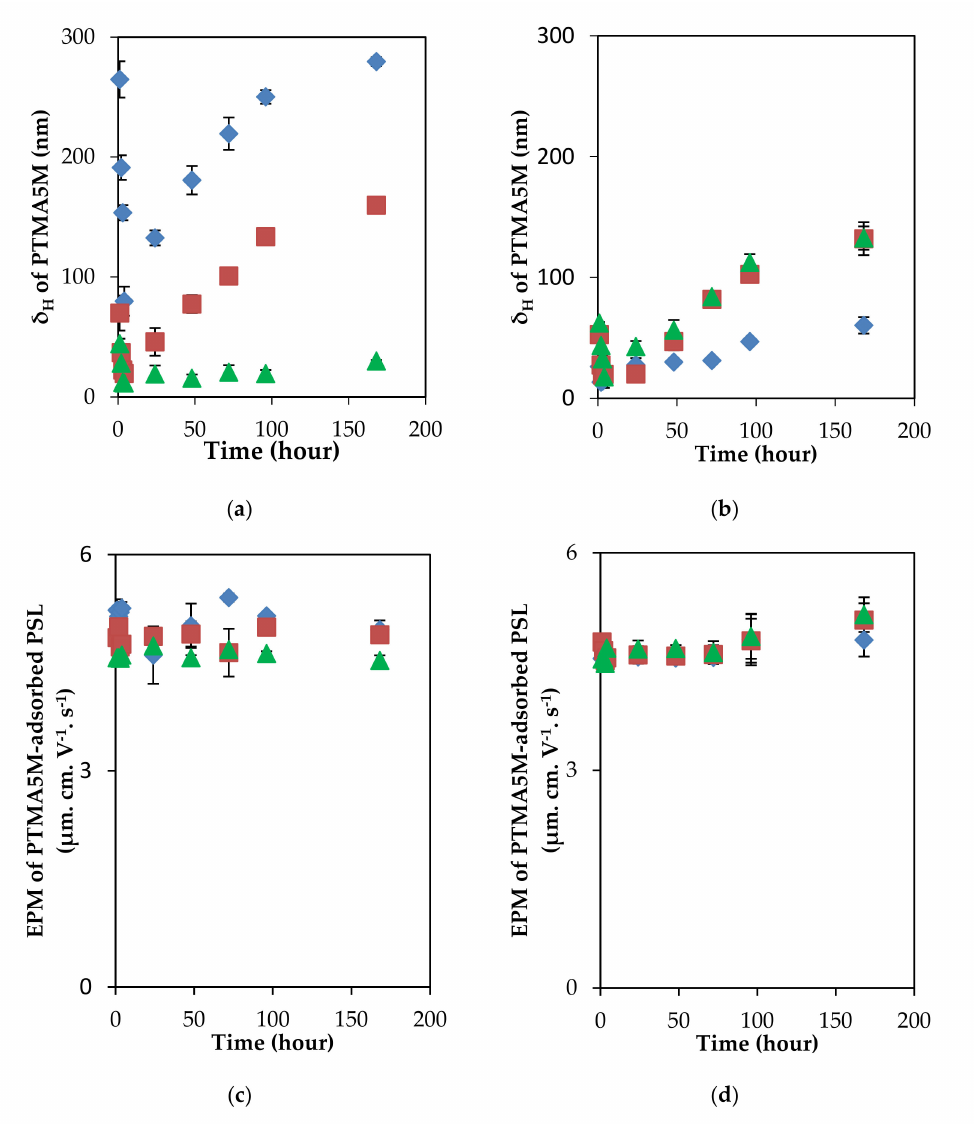
Figure 3. δ H and EPM of PTMA5M–adsorbed PSL colloidal particles as a function of time lapse under two ionic strength conditions. In 0.1 mM KCl: ( a ) δ H , ( c ) EPM and in 10 mM KCl: ( b ) δ H , ( d ) EPM. Initial PTMA5M concentrations: 10 ppm ( (cid:7) ), 5 ppm ( (cid:4) ), 2 ppm ( (cid:78) ). The deviations of different runs are shown by the error